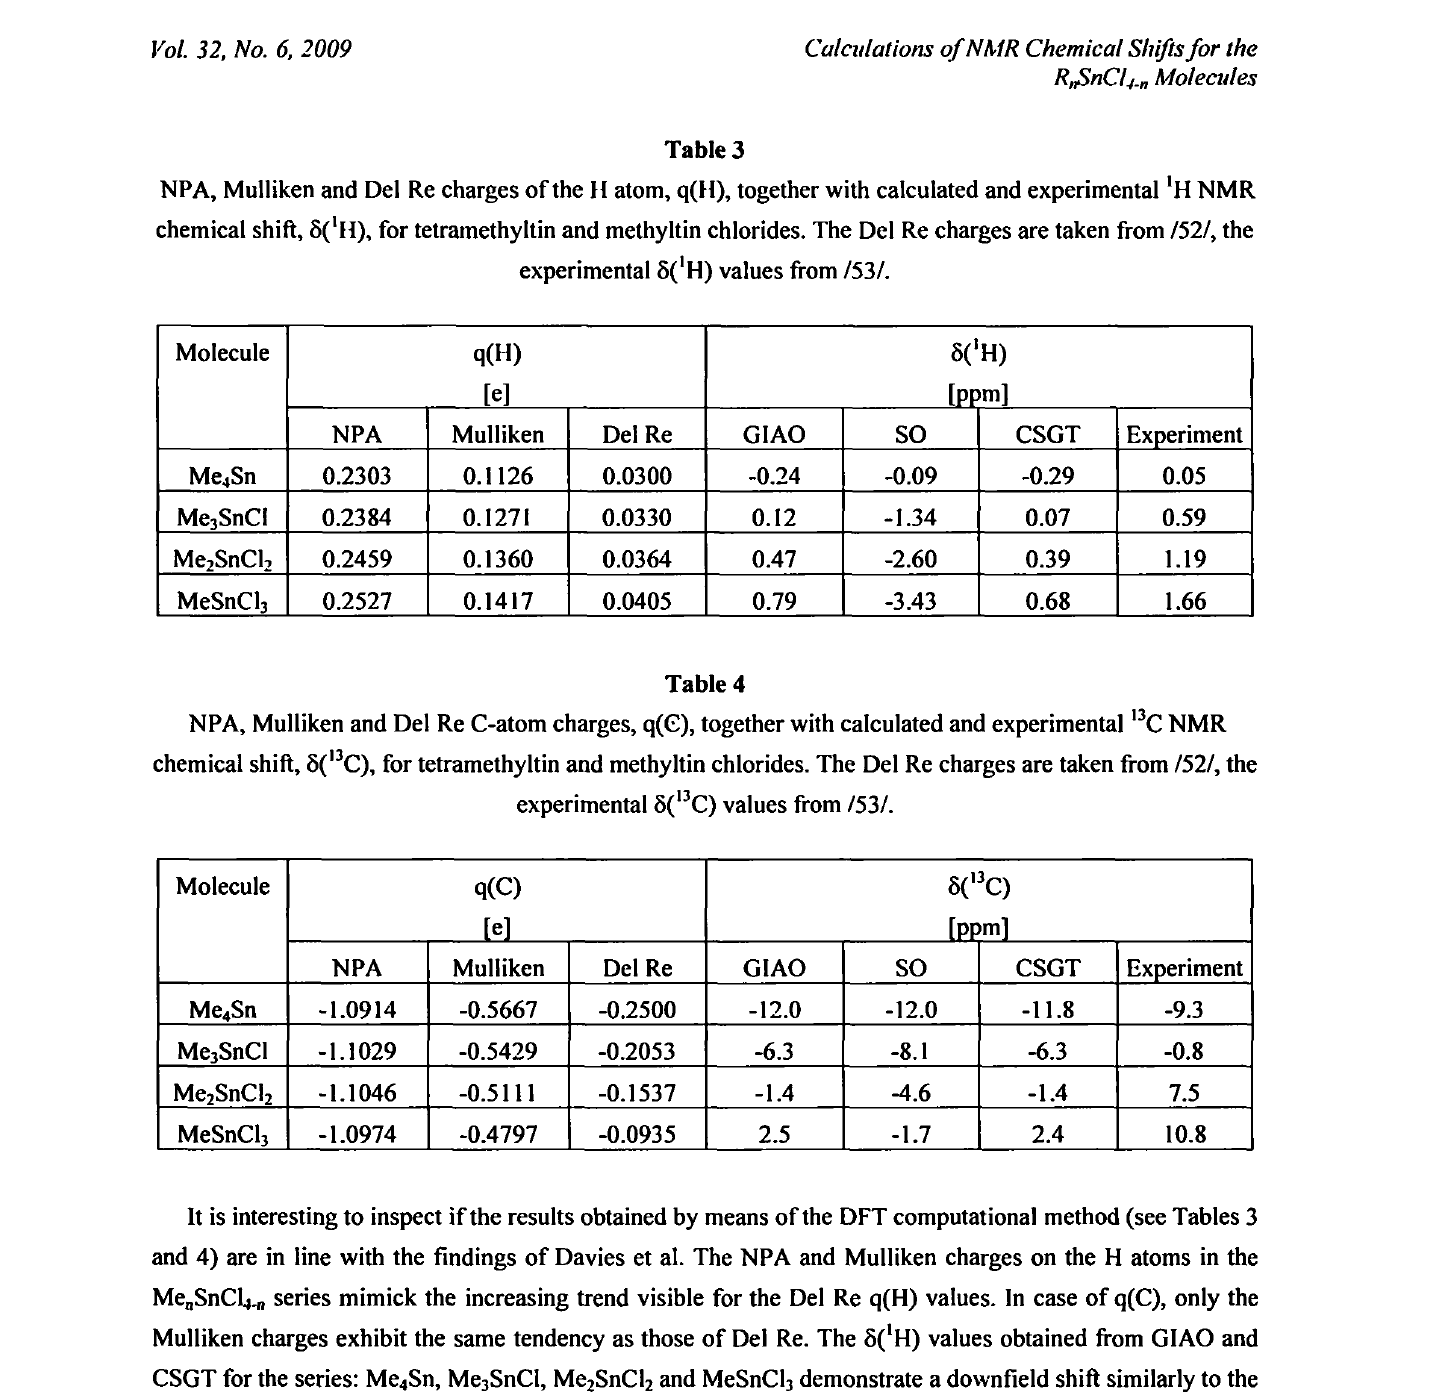
NPA, Mulliken and Del Re charges of the H atom, q(H), together with calculated and experimental Ή NMR chemical shift, δ(Ή), for tetramethyltin and methyltin chlorides. The Del Re charges are taken from 1521, the experimental δ(Ή) values from 7537.